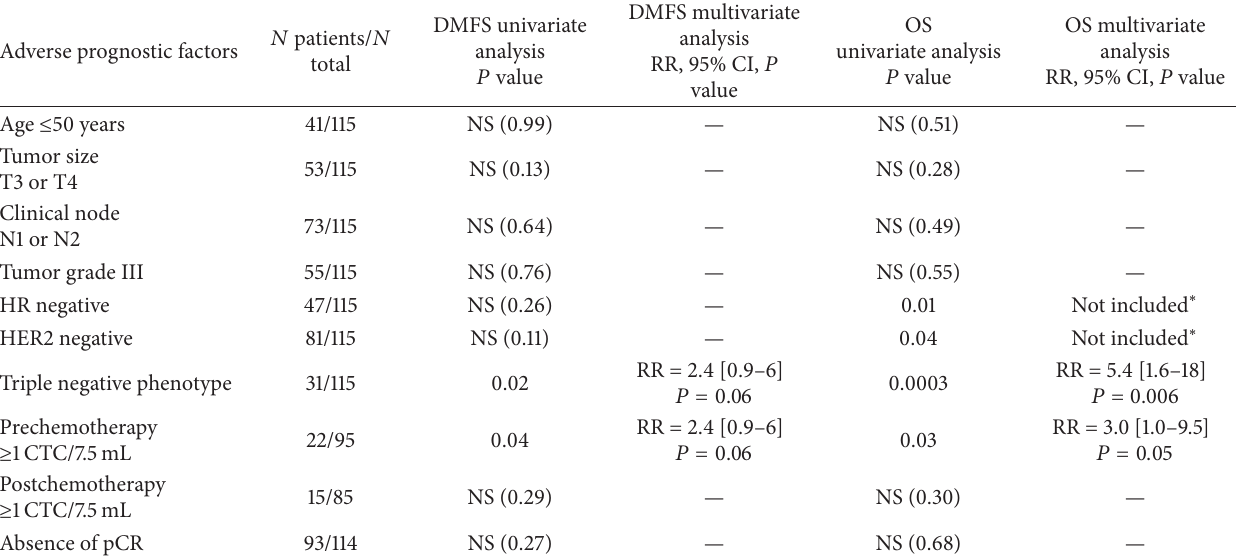
Table 1: Univariate and multivariate analysis on